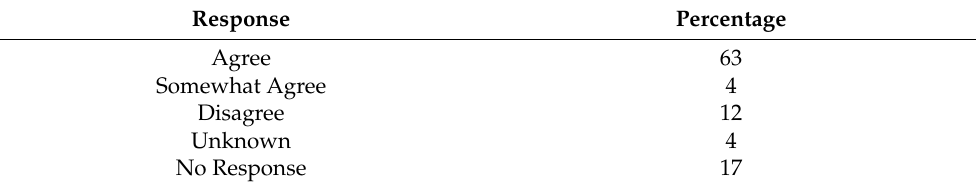
Figure 5. Parking lots and/or surface grassland facing towards the forested areas of major social infrastructures, including: religious establishments ( a ), athletic parks/arenas ( b ), school buildings ( c ), and commercial entities ( d ). Table 1. Response summary about the characteristics of 30 m buffer